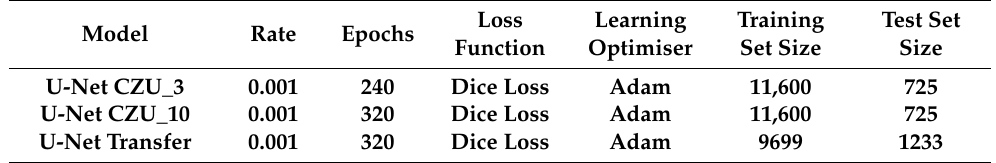
Table 2. Summary of model training